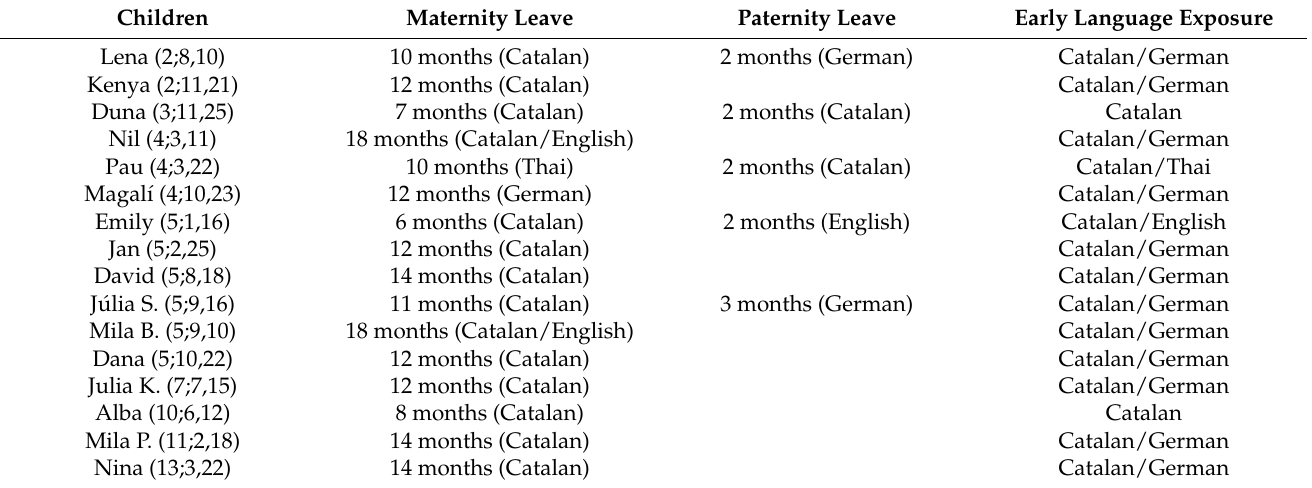
Table 12. Children’s distribution according to maternity/paternity leave, parents’ L1s and early language